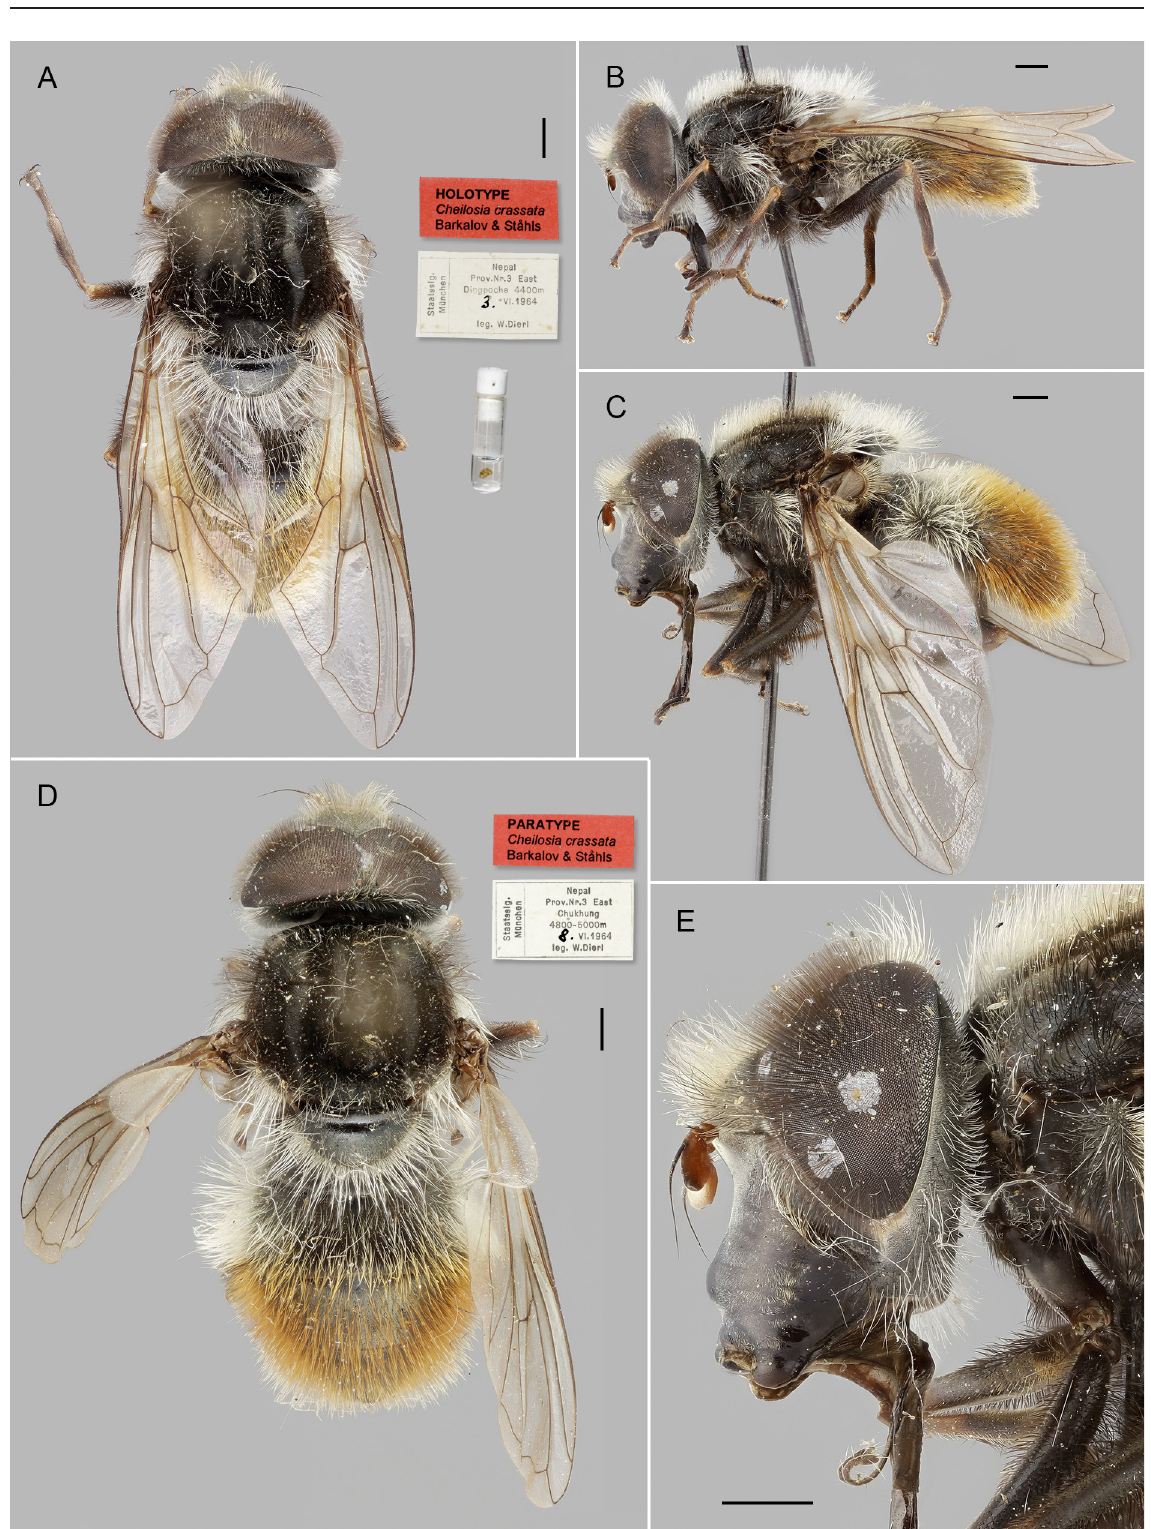
Fig. 12. Cheilosia ( Floccocheila ) crassata sp. nov. A–B . Holotype, ♂ (ZSMC); dorsal and lateral views. C–E . Paratype, ♂ (ZSMC); dorsal and lateral views. Photo: Pekka Malinen, FMNH Luomus. Scale bars = 1